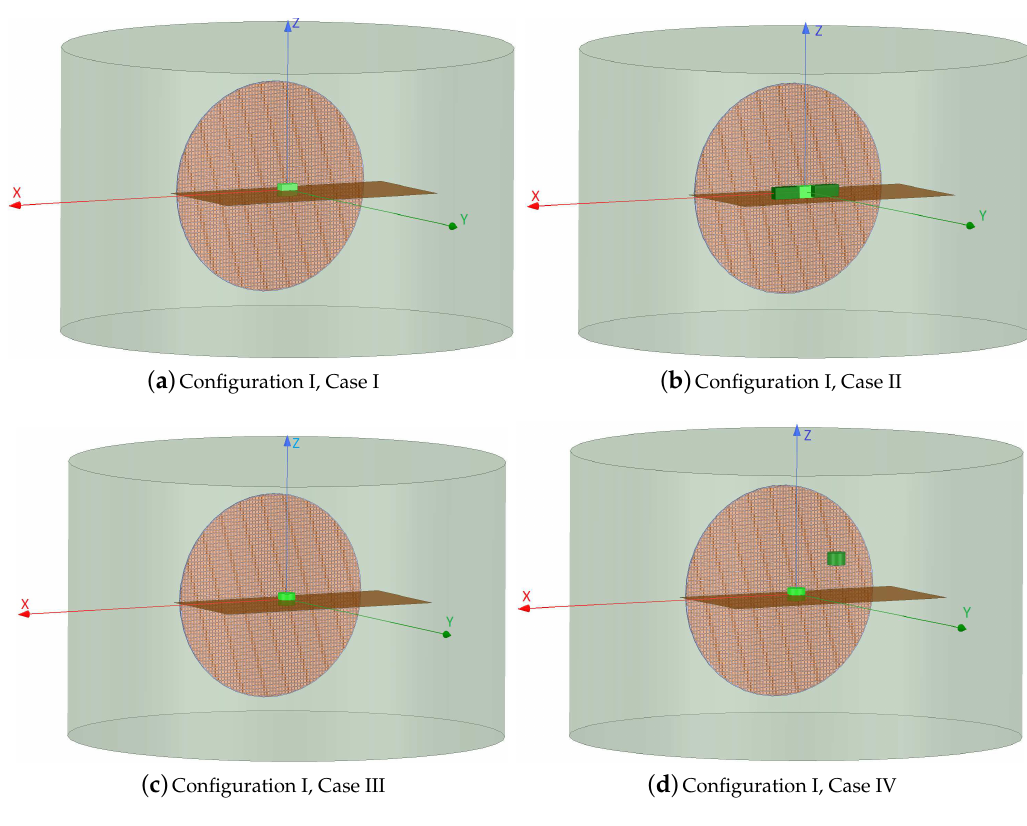
Figure A3. Summary of different case studies under Configuration I of the Bessel beam launcher setup.